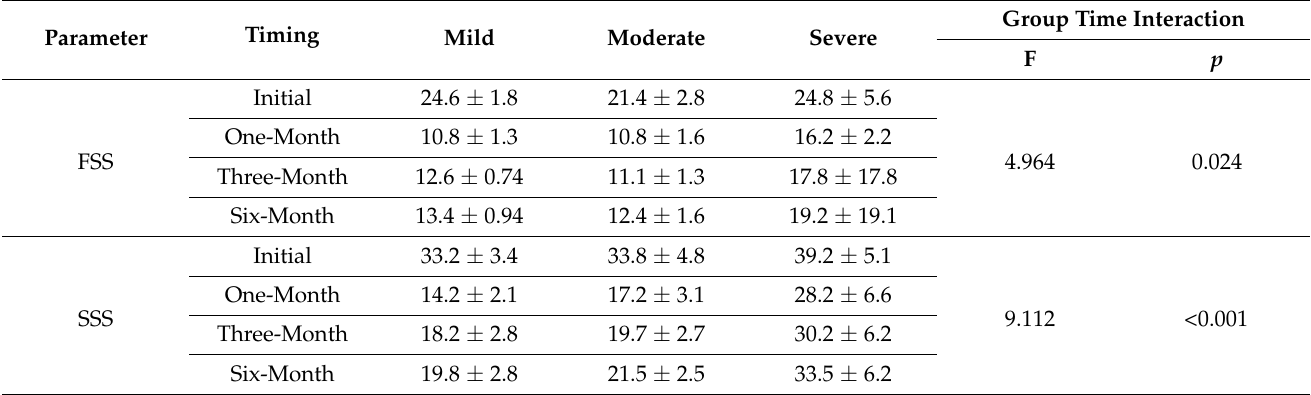
Table 8. Descriptive statistics of FSS and SSS between the three US severity groups over